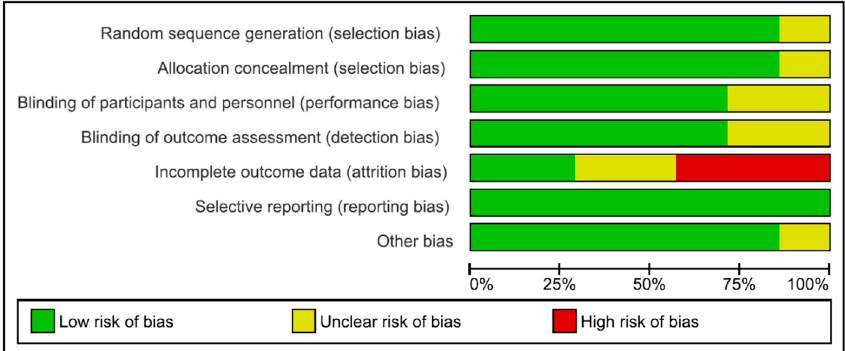
Figure 1. Risk of bias graph.